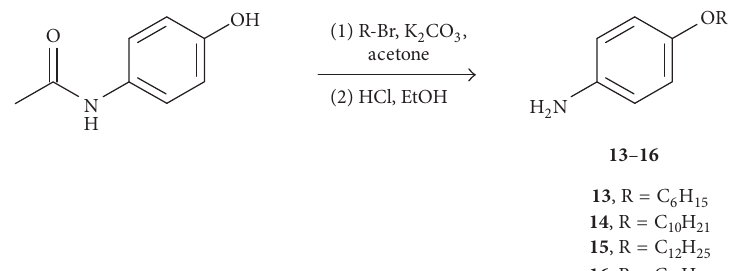
Scheme 2: Preparation of alkylated anilines 13 – 16 .